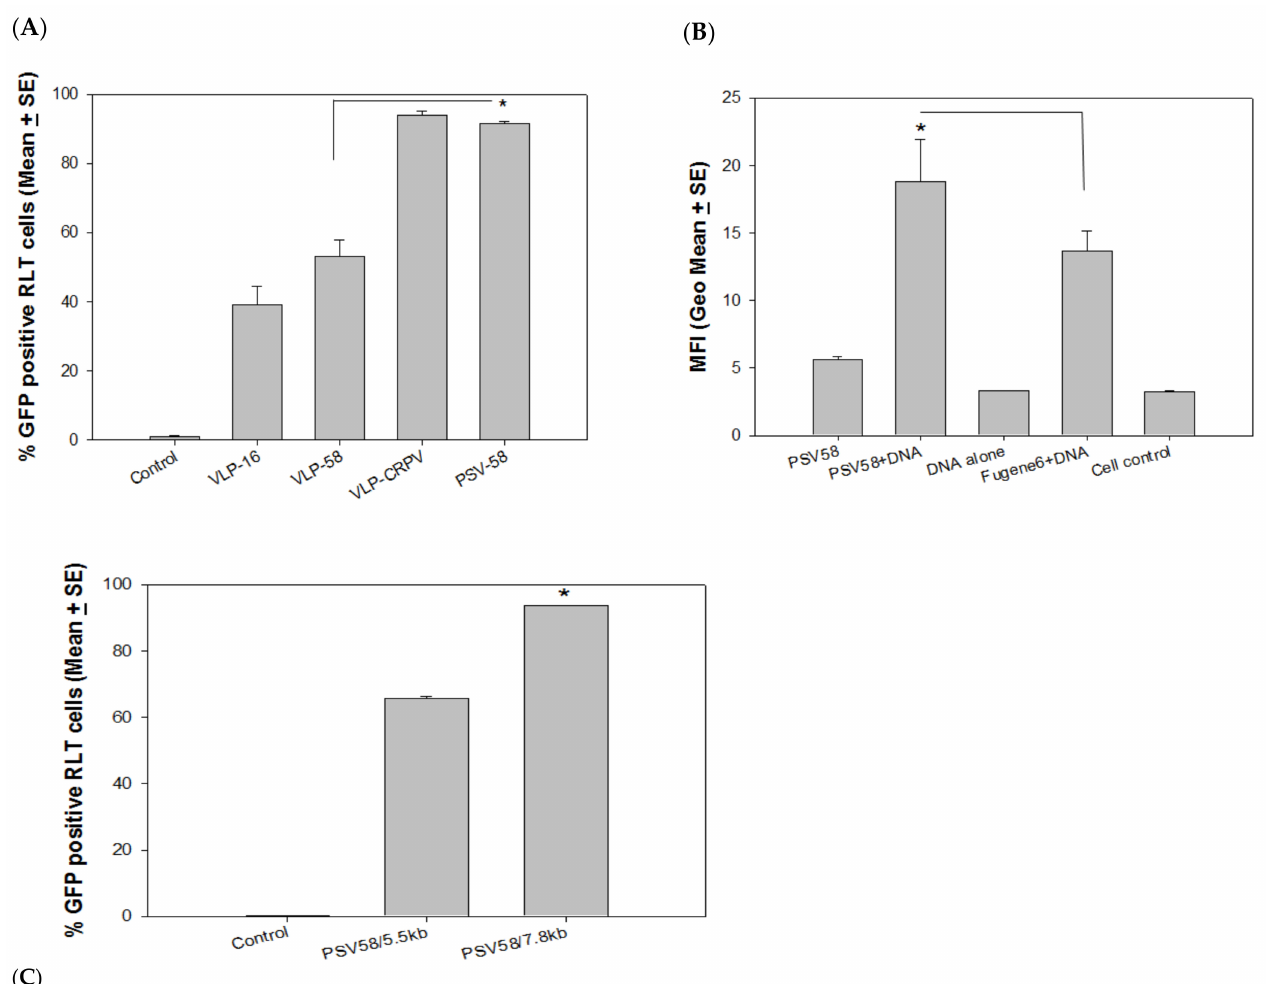
Figure 2. ( A ) PSV58 encapsidating an unrelated 5.5 kb DNA plasmid (PSV58/5.5 kb) showed improved delivery over VLP-58 ( p < 0.05, unpaired Mann Whitney test, indicated by *) that was also comparable to VLP-CRPV. ( B ) External GFP DNA delivered by PSV58 was more efficient than a commercial transfection reagent ( p < 0.05, unpaired Mann Whitney test, indicated by *). No difference was found between PSV58 alone, GFP DNA alone, and medium control ( p > 0.05, unpaired Mann Whitney test). ( C ) Efficiency of external DNA delivery is significantly higher by PSV58 containing the CRPV genome when compared to PSV58/5.5 kb (PCX expression vector, 5.5 kb) genome ( p < 0.05, unpaired Mann Whitney test, indicated by